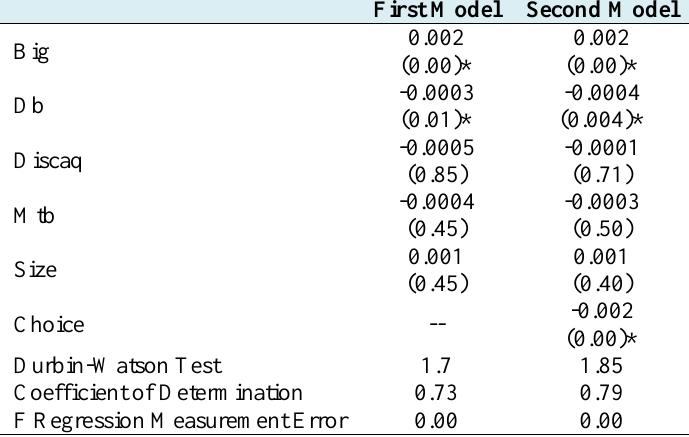
Table 3. Estimation of Coefficients of Research